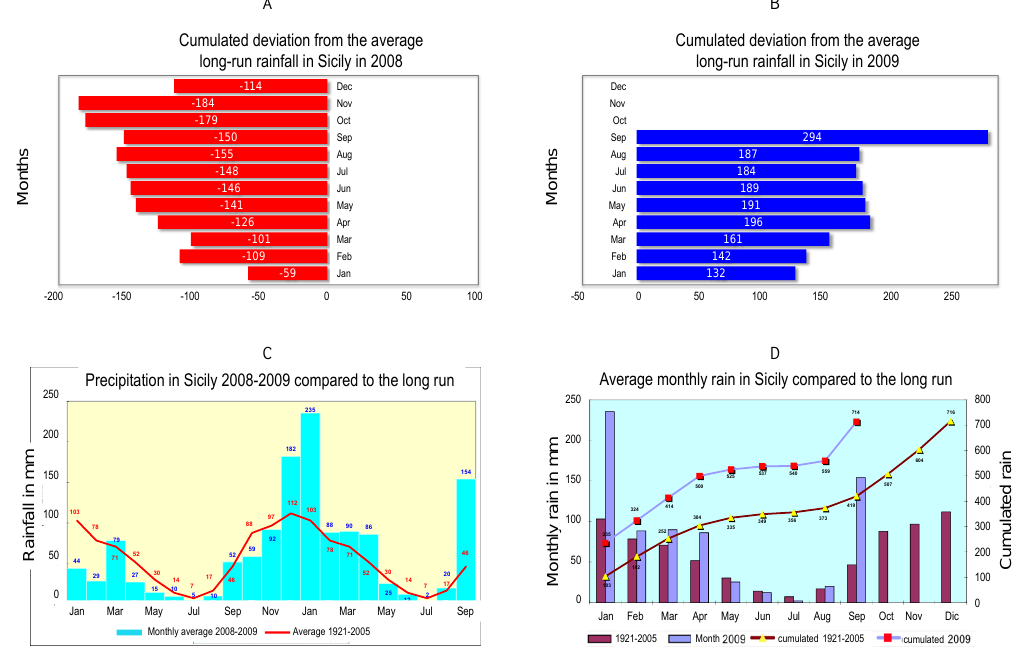
Figure 3. ( A ) The cumulative deviation from the average long-term rainfall record in Sicily in 2008–2009. ( B ) Rainfall in Sicily in 2008–2009 compared to the long-term data; ( C ) Monthly rainfall in mm compared to the long-term data. ( D ) Average monthly rainfall in Sicily compared to the long-term data [19].